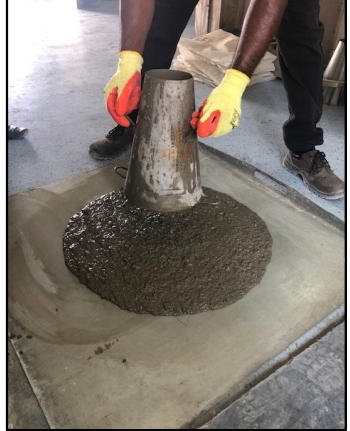
Figure 1. Slump-flow test.